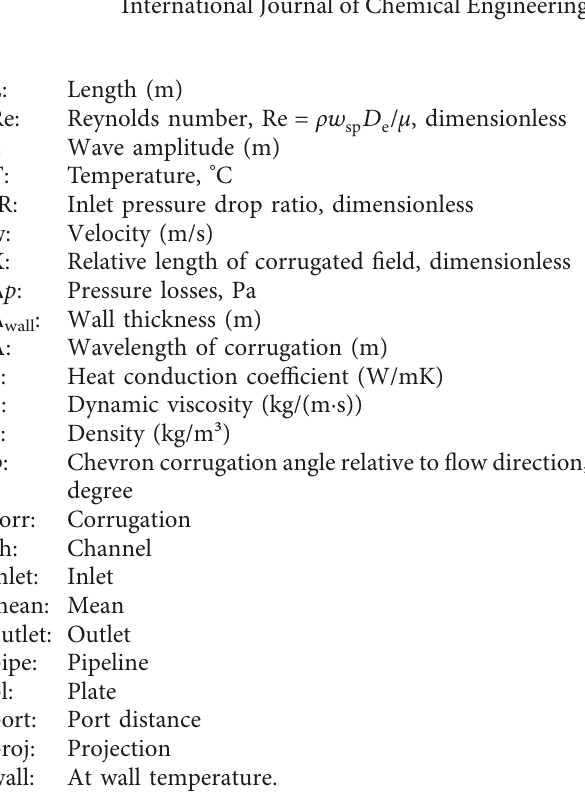
inlet for distribution zone from (i)